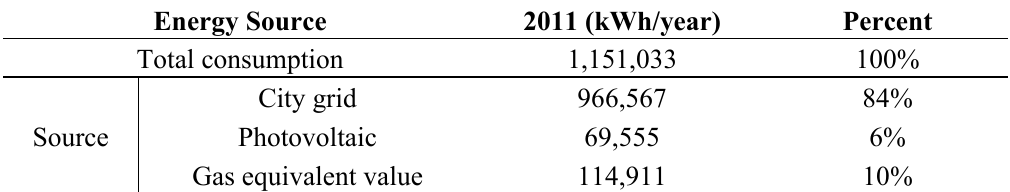
Table 1. Annual whole building energy consumption by fuel (2011).